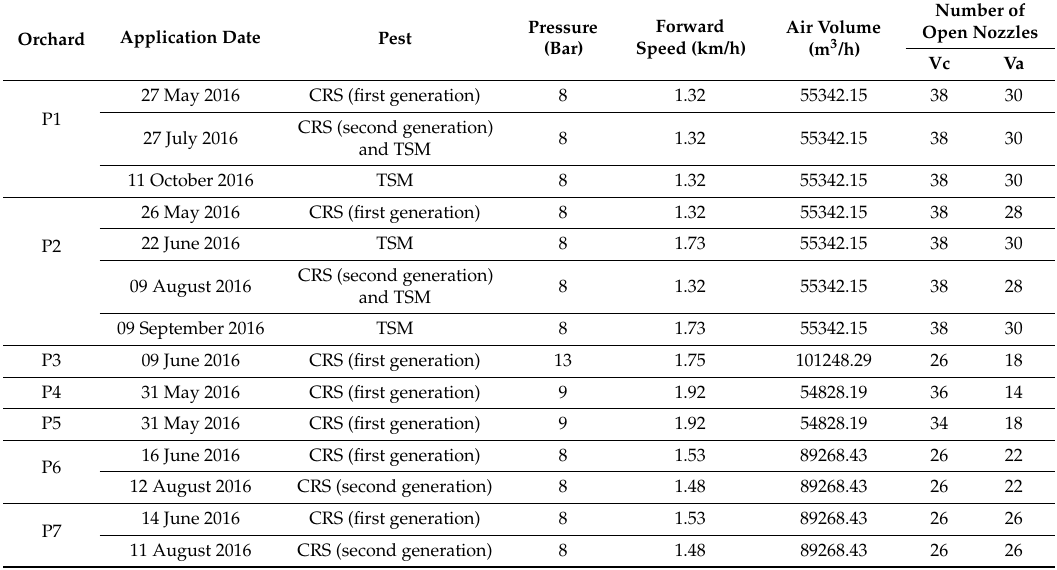
Table 4. Plant protection product (PPP) applications carried out during and set up of the sprayers used.